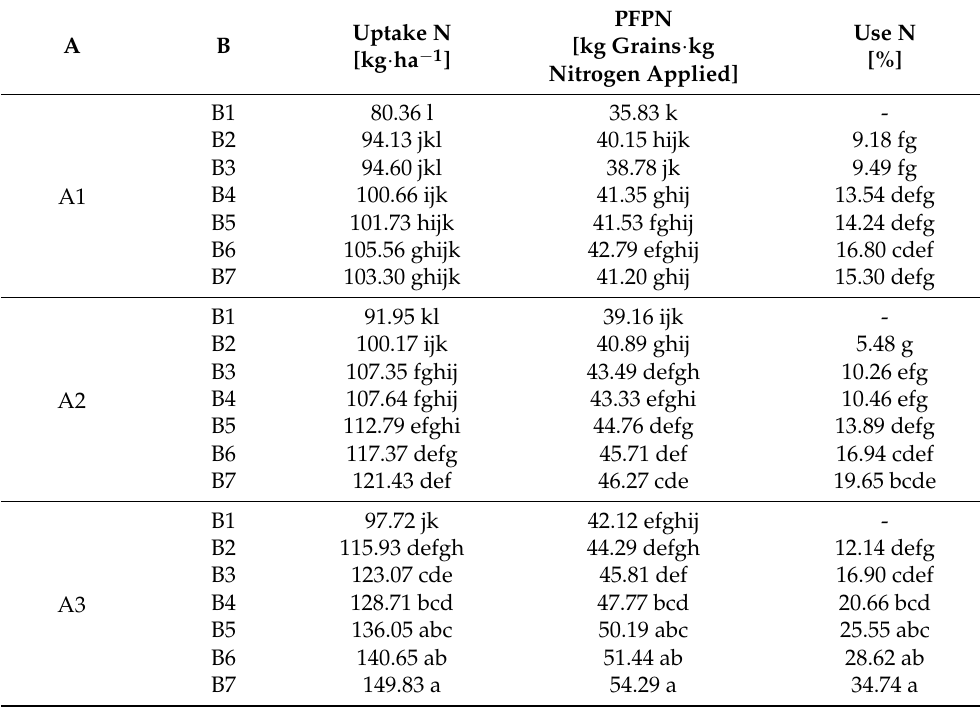
Table 4. Average values of nitrogen application efficiency indicators for the combination of cultivar (A) and fertilizer